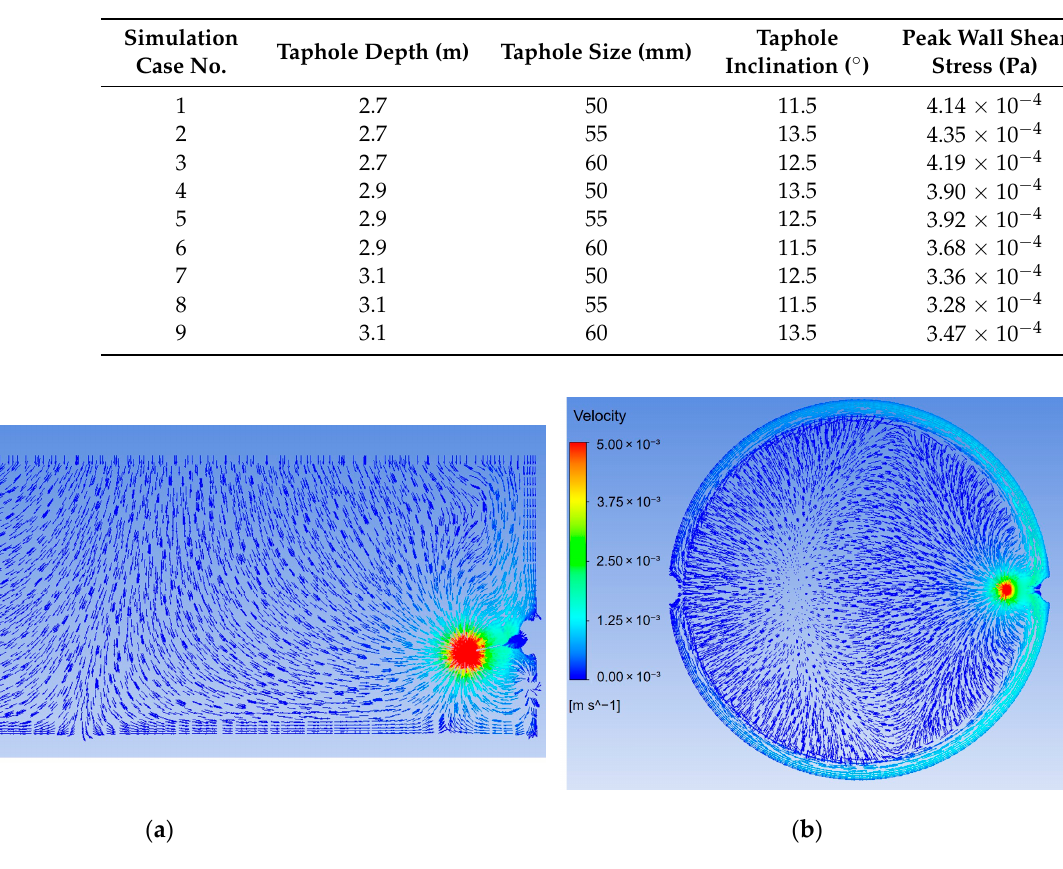
( b ) Figure 9. Shear-stress distributions on the inner-sidewall at a height of 1.5 m from the hearth bottom. ( a ) Original No. 1 BF case; ( b ) No. 7 Case.